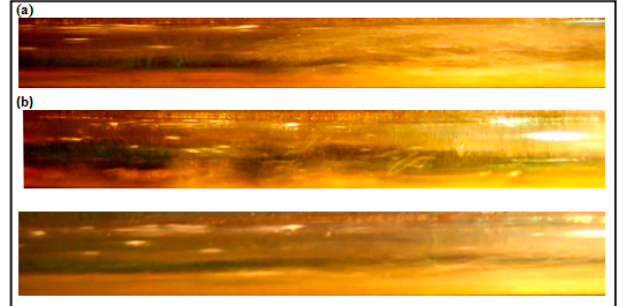
Figure 14. ( a ) Pseudo Slug flow without DRP (V sl = 1.03 m/s, V sg = 3.08 m/s) ; ( b ) Transition from Pseudo Slug to Wavy Annular flow regime using 100 ppm.